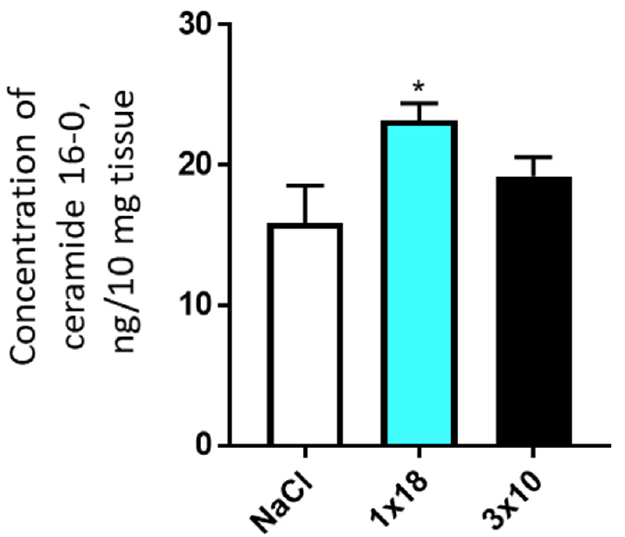
Figure 5. Concentration of ceramide 16-0 in the substantia nigra of mice 2 weeks after the adminis- tration of 1-methyl-4-phenyl-1,2,3,6-tetrahydropyridine, once at a single dose of 18 mg/kg or three times at a single dose of 10 mg/kg. * p < 0.05, significant differences compared to the controls. 3.3.3. Concentrations of Sphingosine, Sphinganine, and Sphingosine-1-Phosphate in the Striatum and Substantia Nigra in Mice after MPTP Administration The concentrations of sphingosine, sphinganine, and sphingosine-1-phosphate varied significantly in the control mice, both in the striatum and in the SN (Figure 6). In both areas of the nigrostriatal system, the maximum concentration was displayed by sphingosine and the minimum one was shown by sphinganine. In experiments with single and triple administration of MPTP, only the concentration of sphingosine-1-phosphate changed and only in the SN. In both experiments, it increased in comparison with the controls by about 15% (Figure